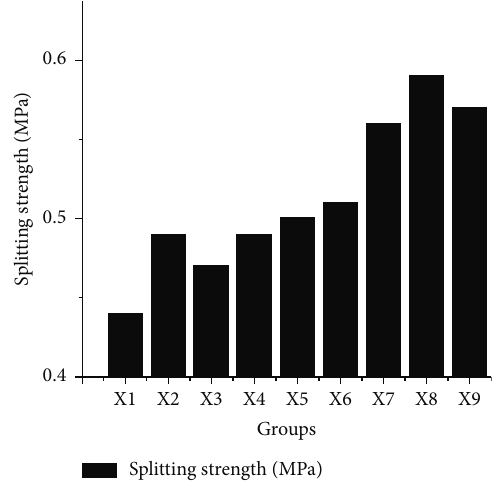
Figure 15: Splitting strength bar